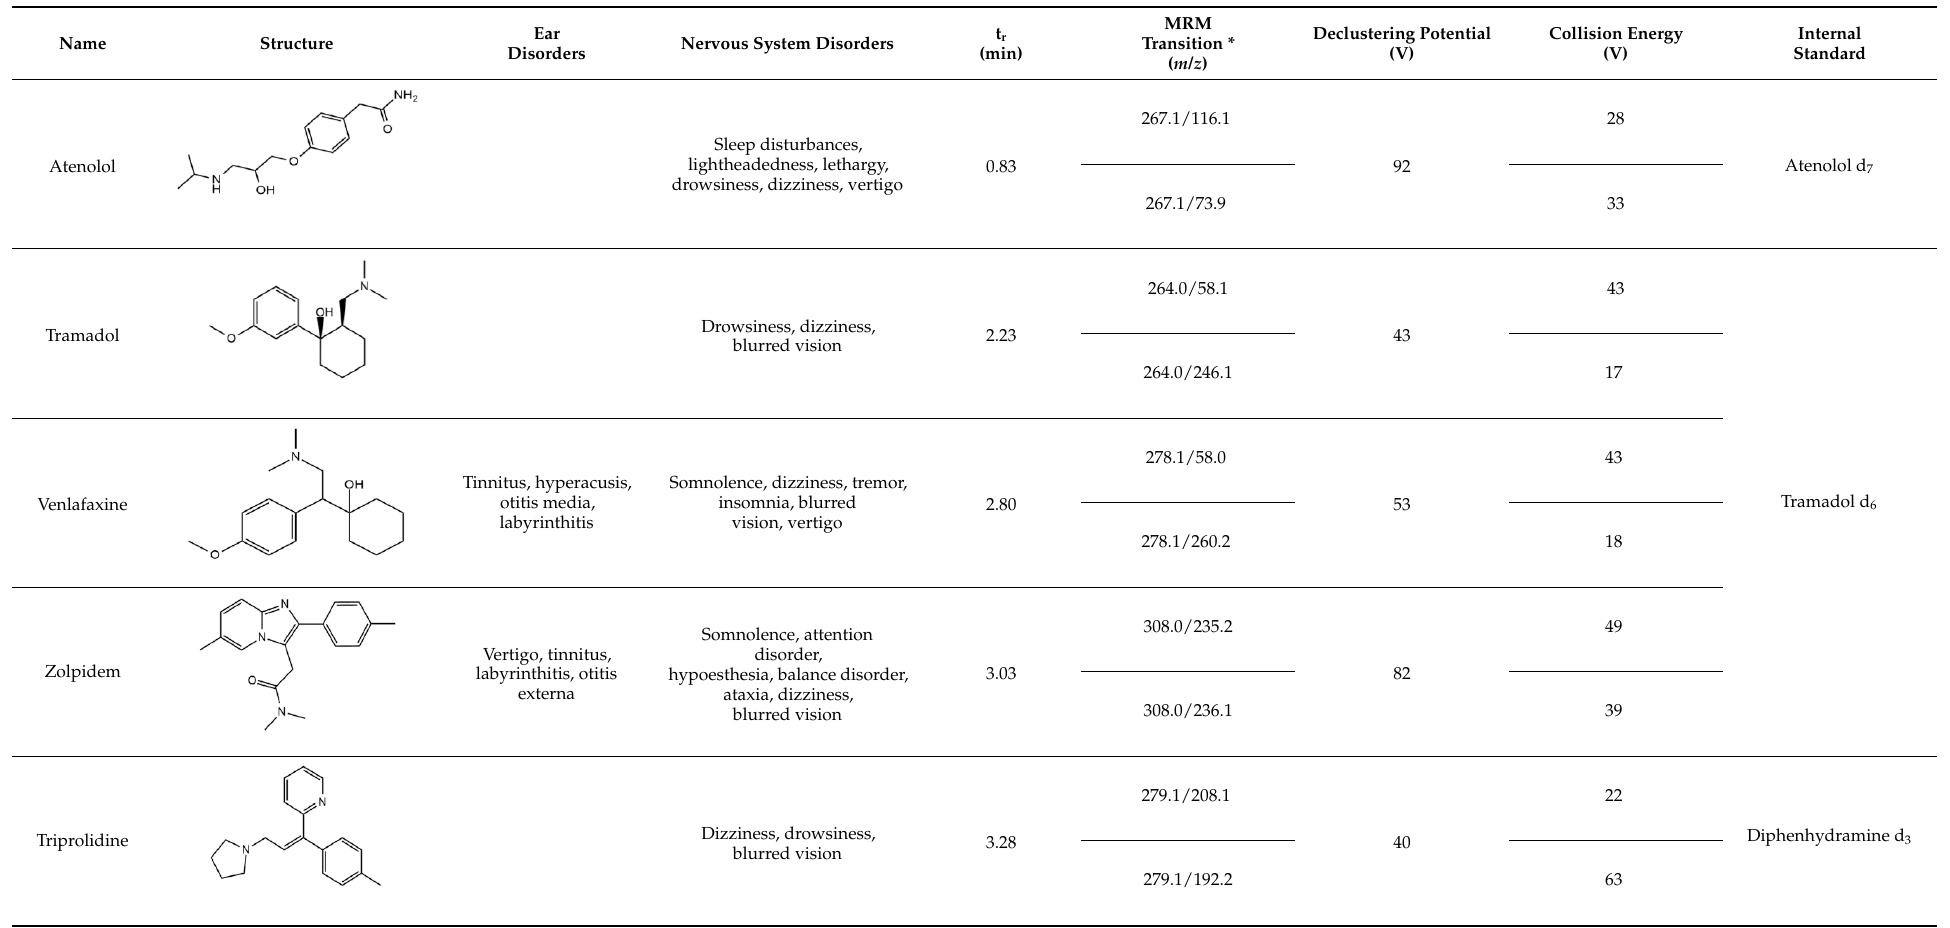
Table 1. Names, structures, adverse effects on the ear and on the nervous system, retention times, optimized MRM transitions (Quantifier and Qualifier), and final MS/MS parameters of the target analytes.